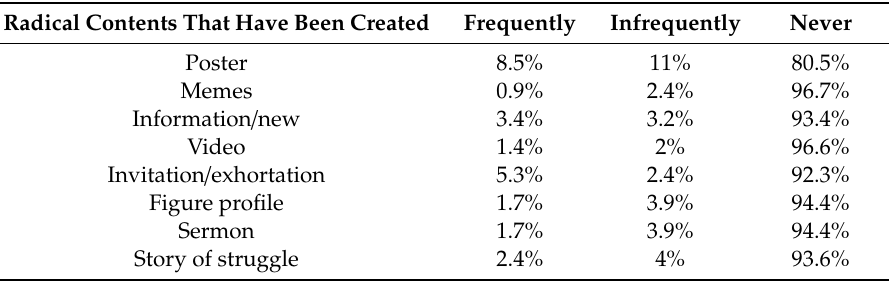
Table 6. Radical Content Created by